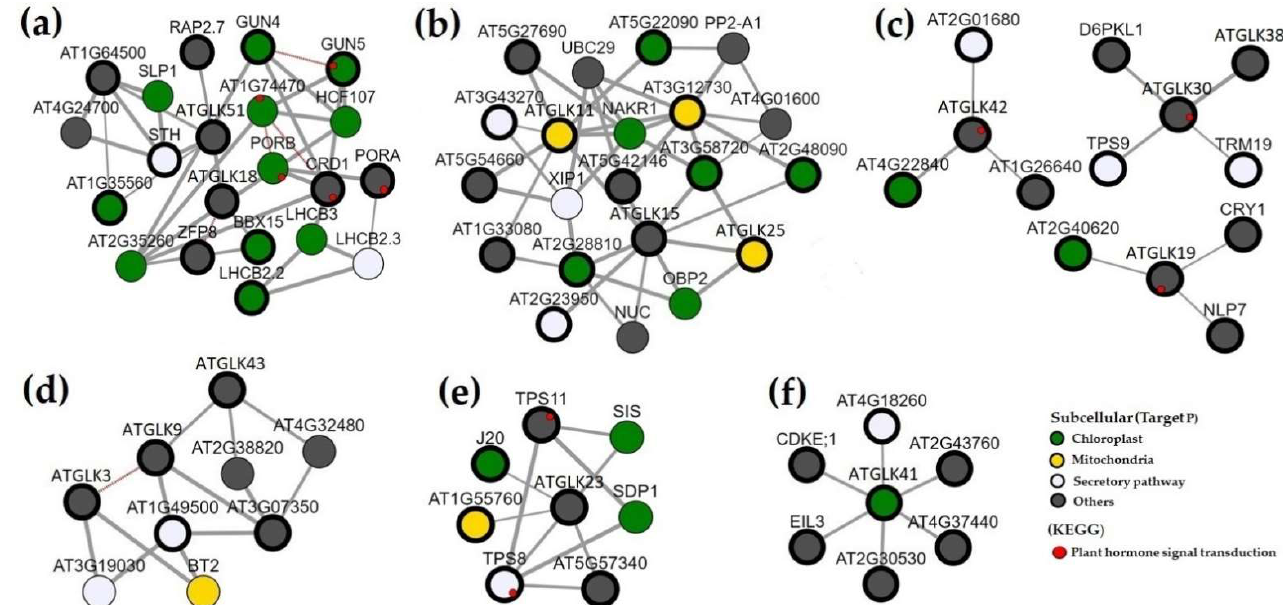
Figure 10. Co-expression networks of AtGLK genes. Co-expression networks among AtGLK and photosynthesis related genes ( a ), flower development related genes ( b ), water deprivation related genes ( c ), stress responsive genes ( d ), cold stress responsive genes ( e ) and phosphate starvation related genes ( f ). The different colors of node represent the subcellular targets and pathways. The rich circle represents the most important known targets for AtGLKs , and the thickness of the edge represents the strength of interaction between the nodes.